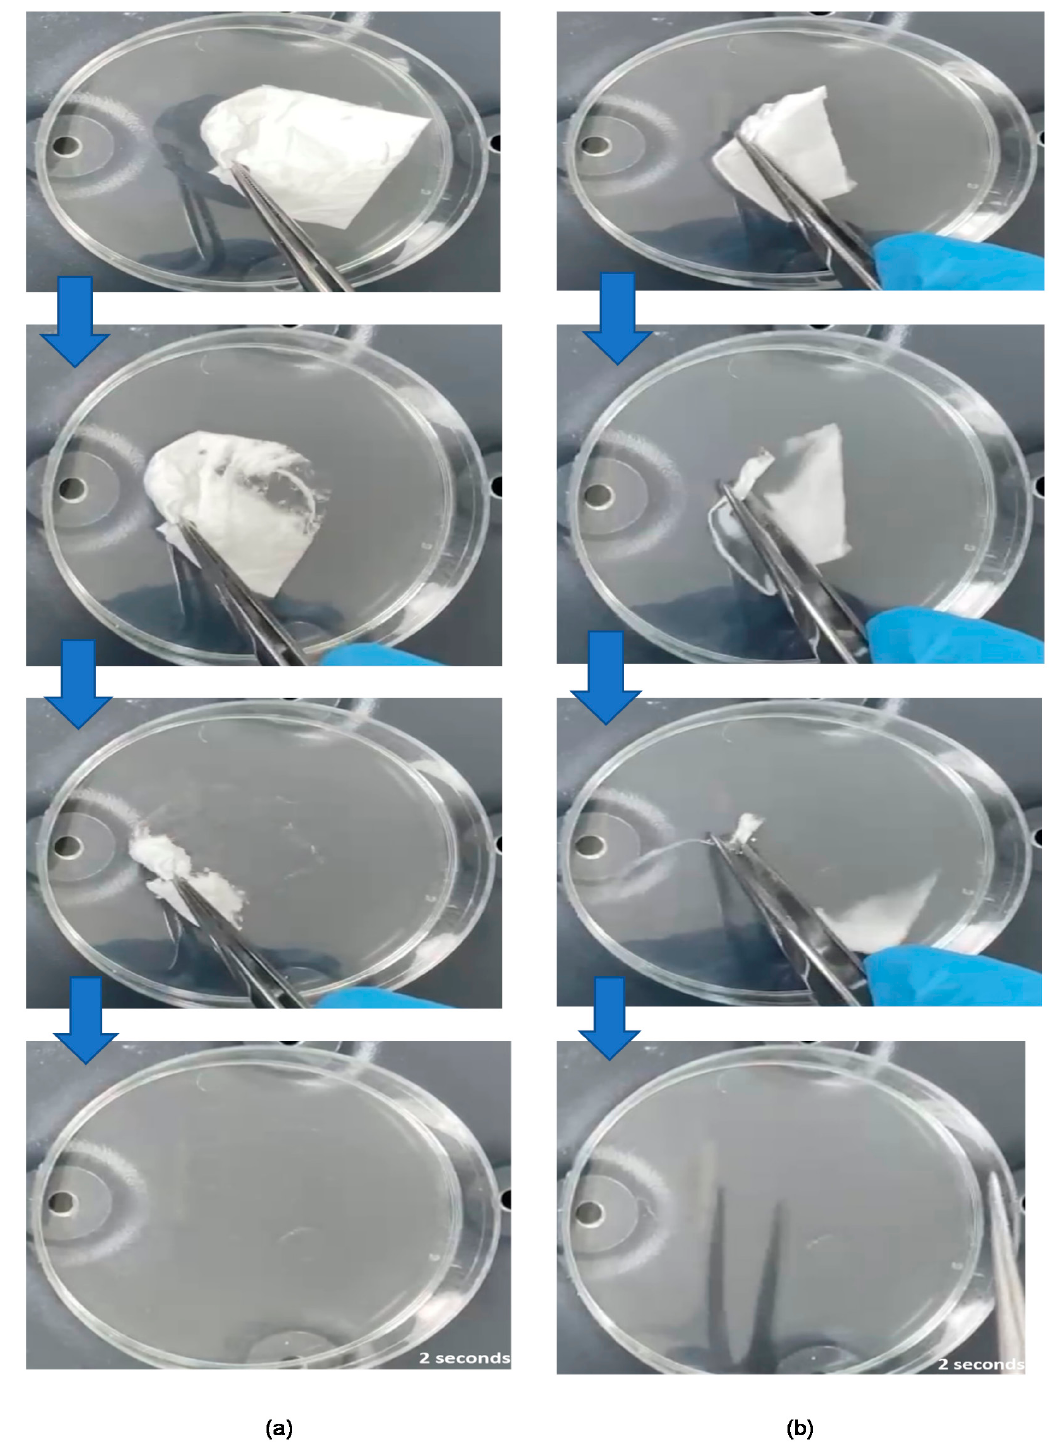
Figure 6. Photos of the disintegration of ( a ) blank fibers, and ( b ) drug-loaded fibers, showing that both fibrous systems have a disintegration time of 2 s.